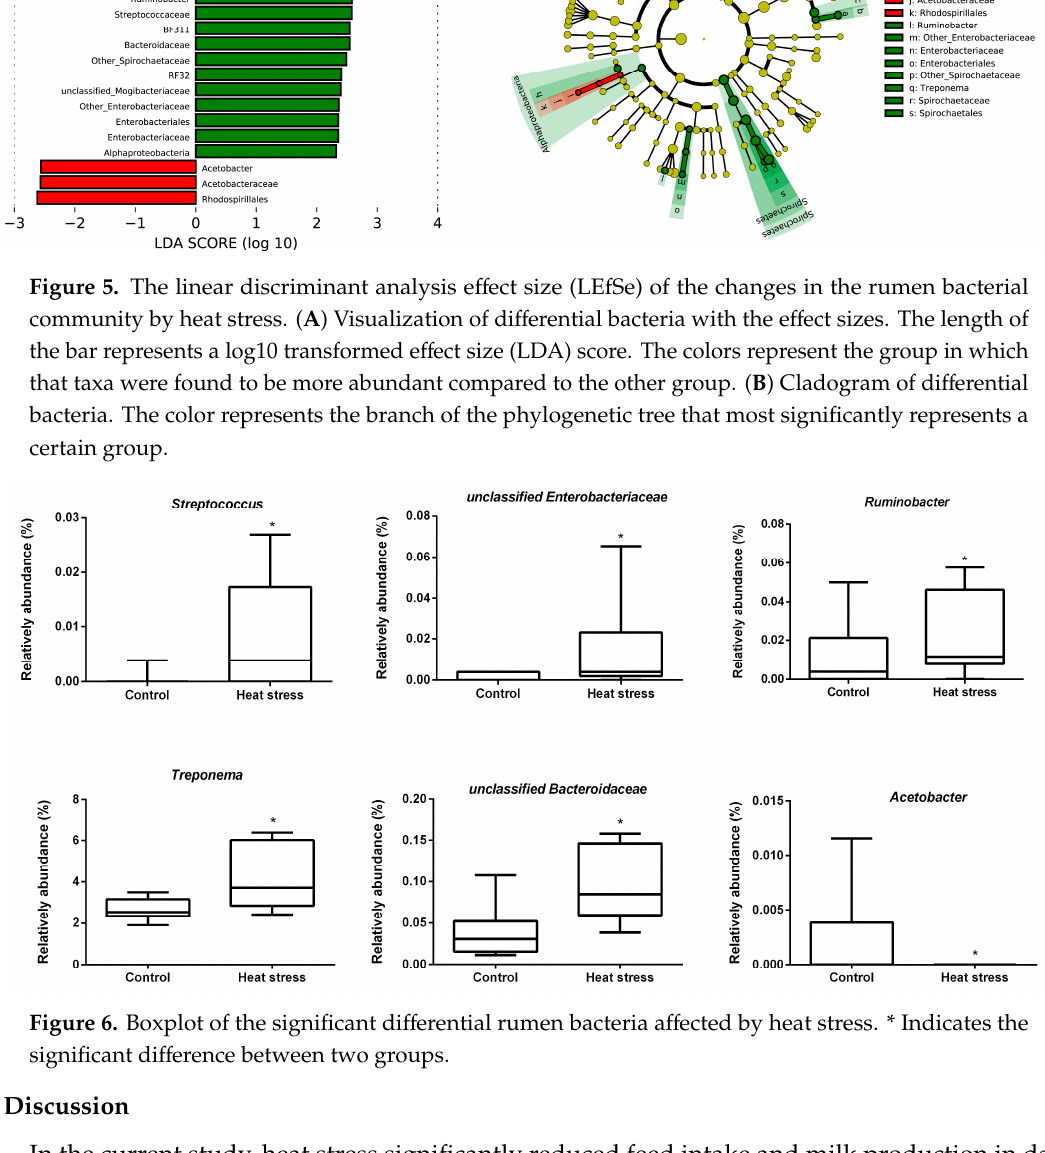
Figure 6. Boxplot of the significant differential rumen bacteria affected by heat stress. * Indicates the significant difference between two groups.